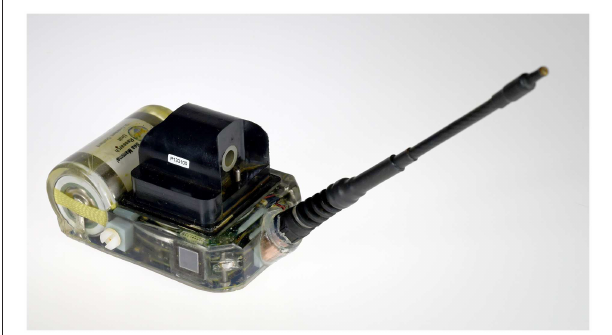
FIGURE 2 | A CTD-SRDL tag, featuring a miniaturized CTD on top of the core unit, with the microcontroller below, the wet/dry sensor on the frontside, the battery on the rear, and the Argos antenna pointing